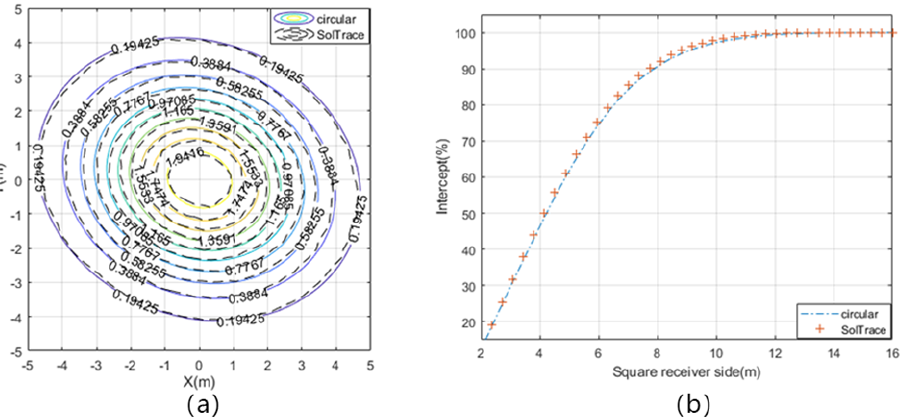
Figure 5. ( a ) Flux density distribution computed by the circular Gaussian model and SolTrace (kW/m 2 ), ( b ) intercepts computed by the circular Gaussian model and SolTrace.